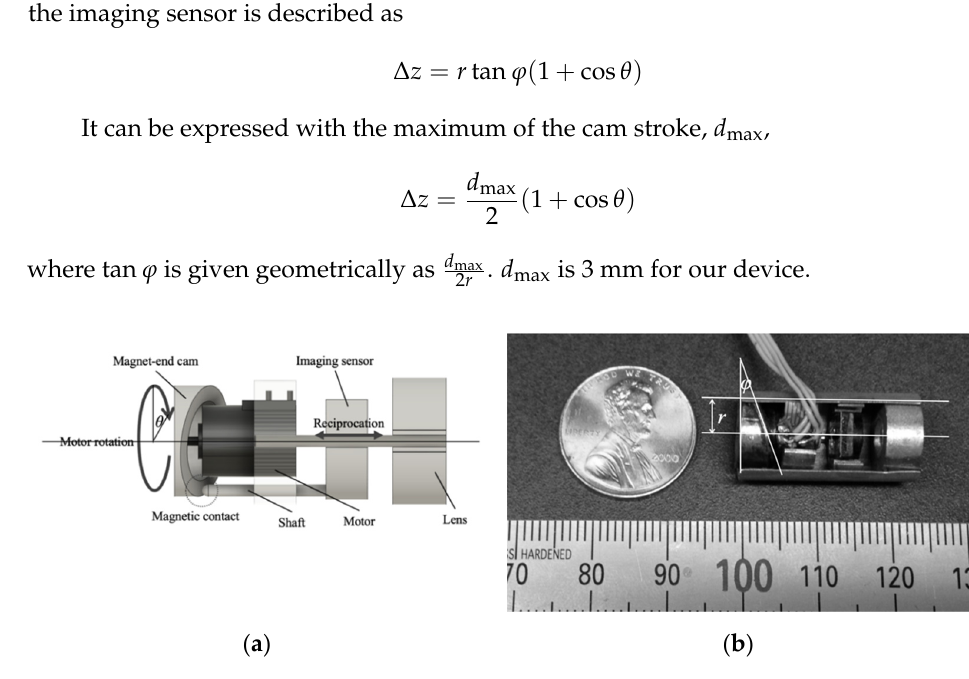
Figure 2. Prototype: ( a ) schematic diagram and ( b ) appearance of internal mechanism.